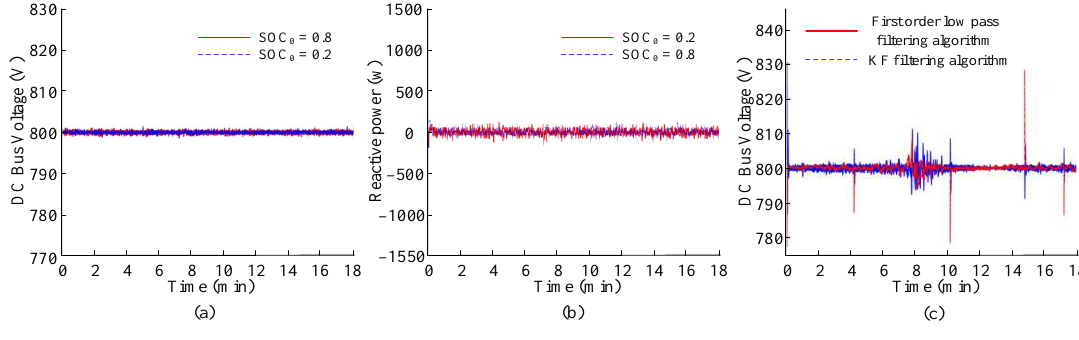
Figure 11. FC and EL power change curve.